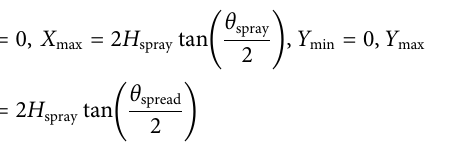
Frontiers in Materials |